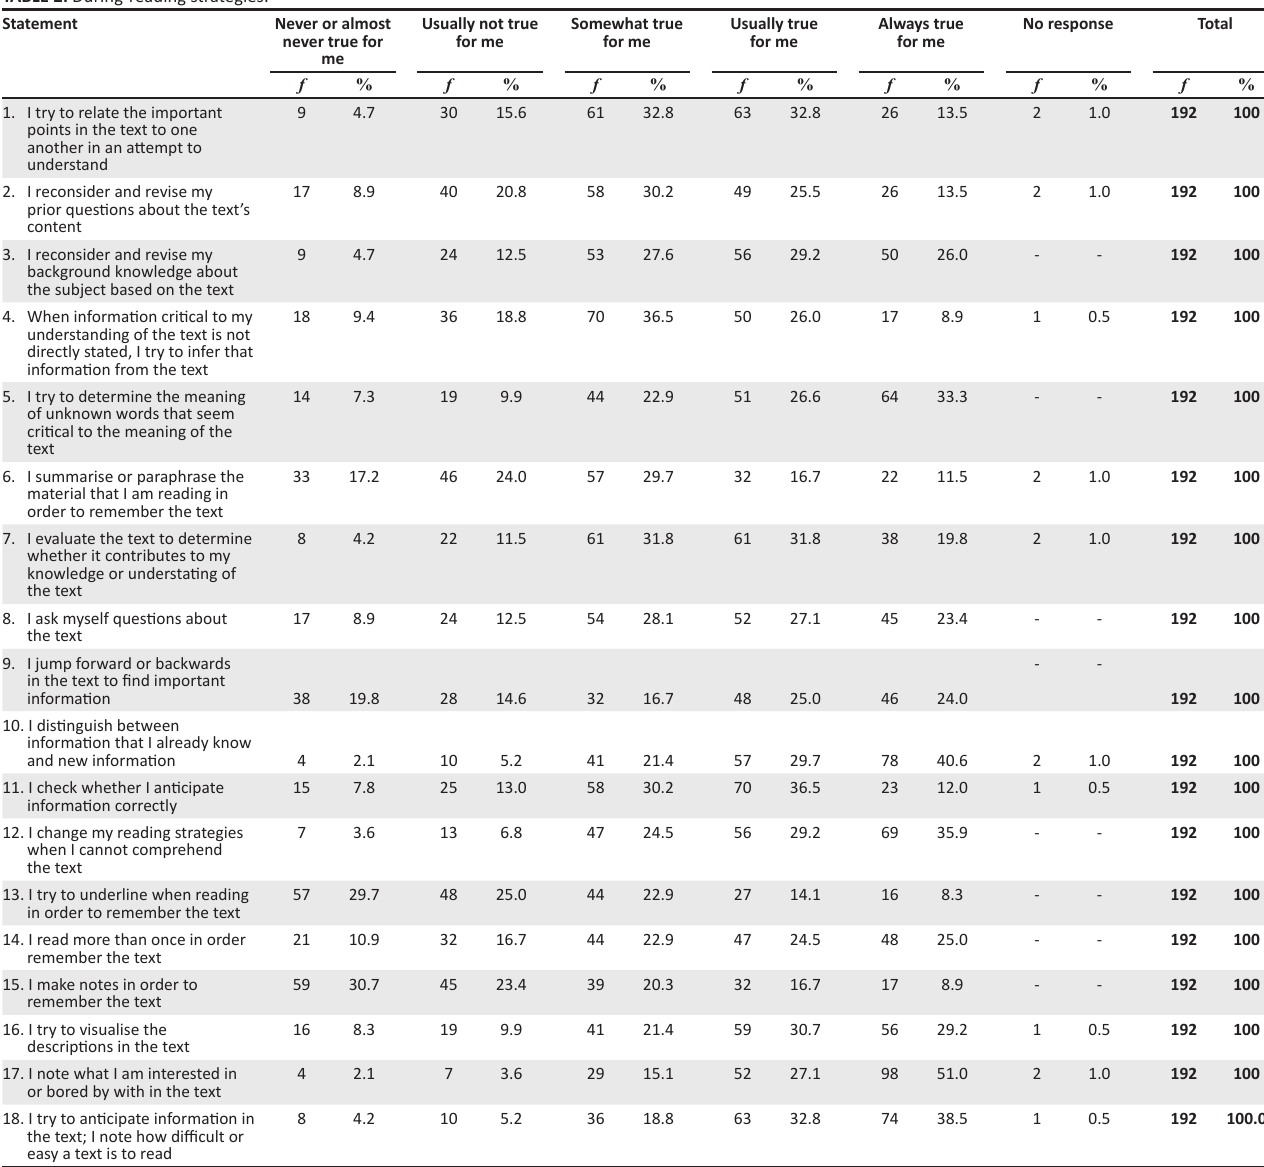
TABLE 2: During-reading strategies.